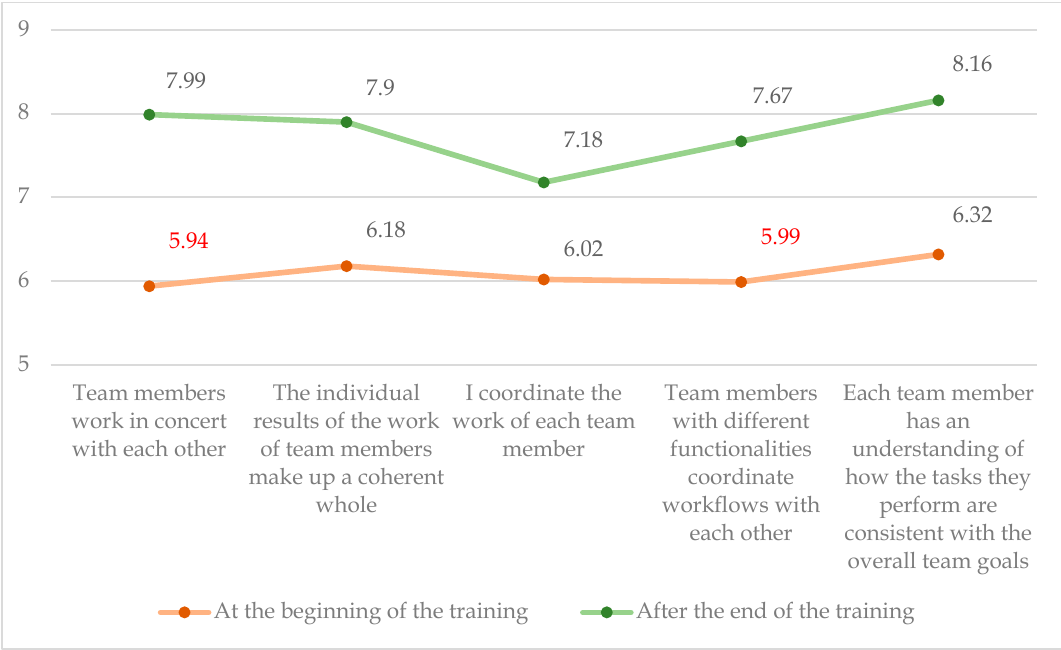
Figure 4. Results of answers to the block of questions “Coordination of team actions” (in comparison of answers to questions at the beginning and after the end of the training).